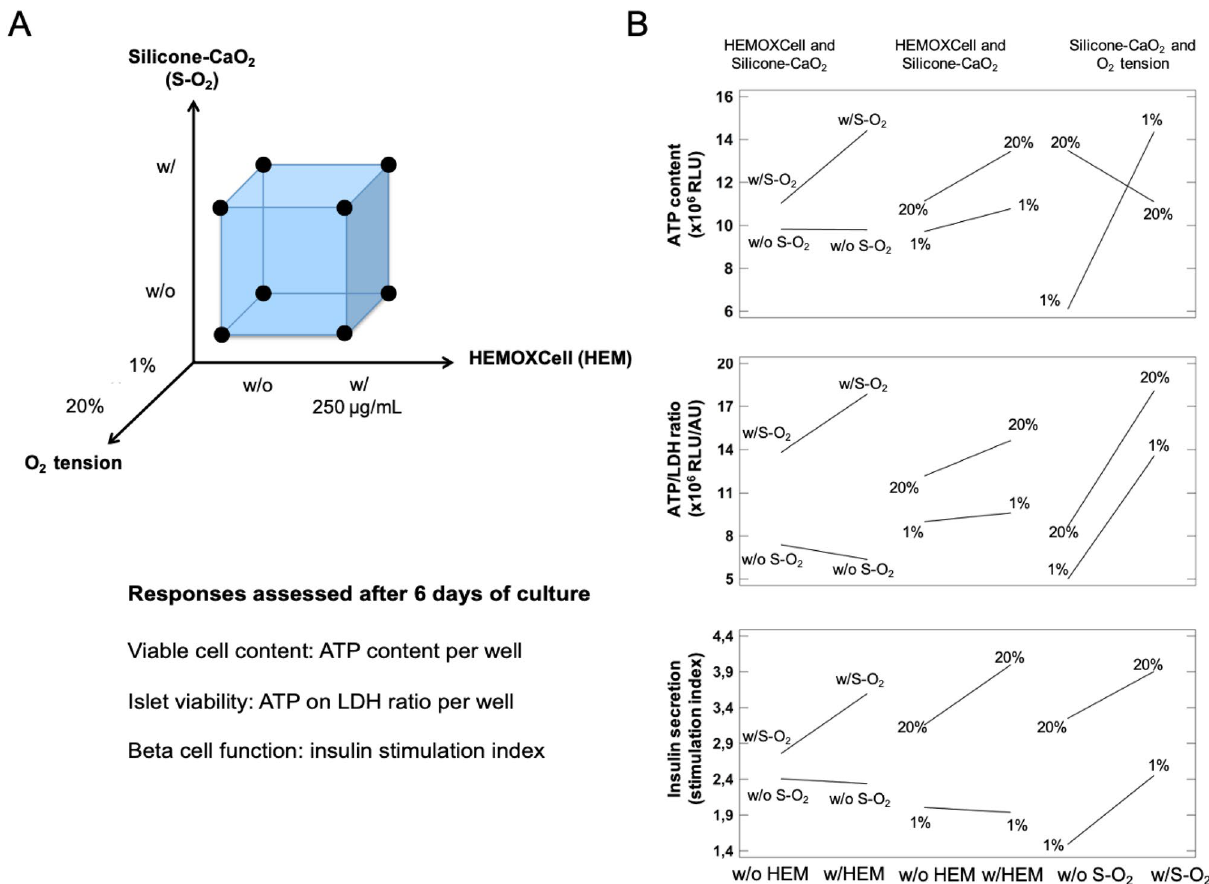
Figure 1. Screening experimental design. ( A ) The screening of the oxygenation strategies was done on MPIs encapsulated in alginate macrobeads using a full factorial design 2 3 . The three factors studied and their levels were: w/o or w/HEMOXCell (HEM), w/o or w/silicone-CaO 2 (S-O 2 ), and w/ 1% O 2 or 20% O 2 tension. The response variables assessed after 6 days of culture were the intracellular ATP content per well (RLU), ATP/ LDH viability ratio per well (RLU/AU), and the insulin stimulation index. ( B ) Interaction plots of the screening DoE. Interactions involving HEMOXCell and silicon-CaO 2 , HEMOXCell and O 2 tension, silicone-CaO 2 and O 2 tension are displayed concerning ATP content, ATP/LDH ratio, and insulin stimulation index.